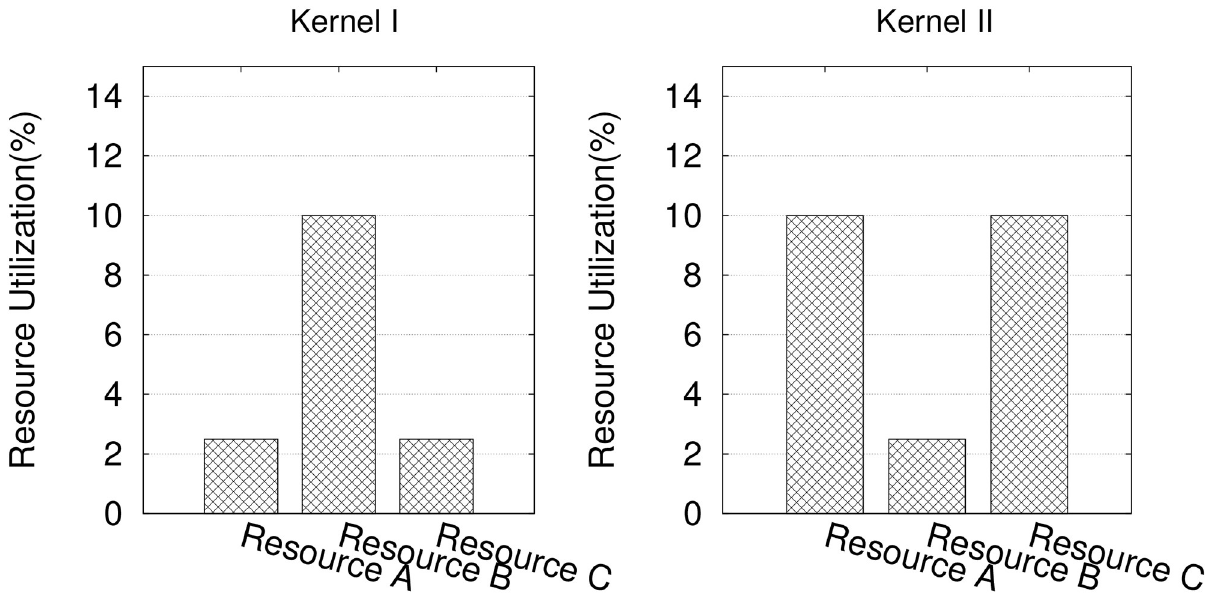
Fig 2. Normalized resource use per thread of two different kernels.